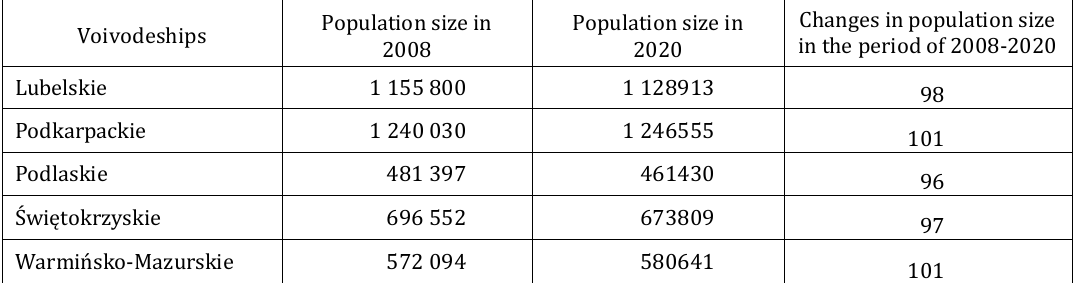
Table 2. Changes in population size in rural areas in the voivodeships of Eastern Poland during the period 2008–2020 (Source: calculations of the authors based on data from the Local Data Bank of Statistics, Poland) Changes in population size Population size in Population size in Voivodeships in the period of 2008-2020 2008 2020